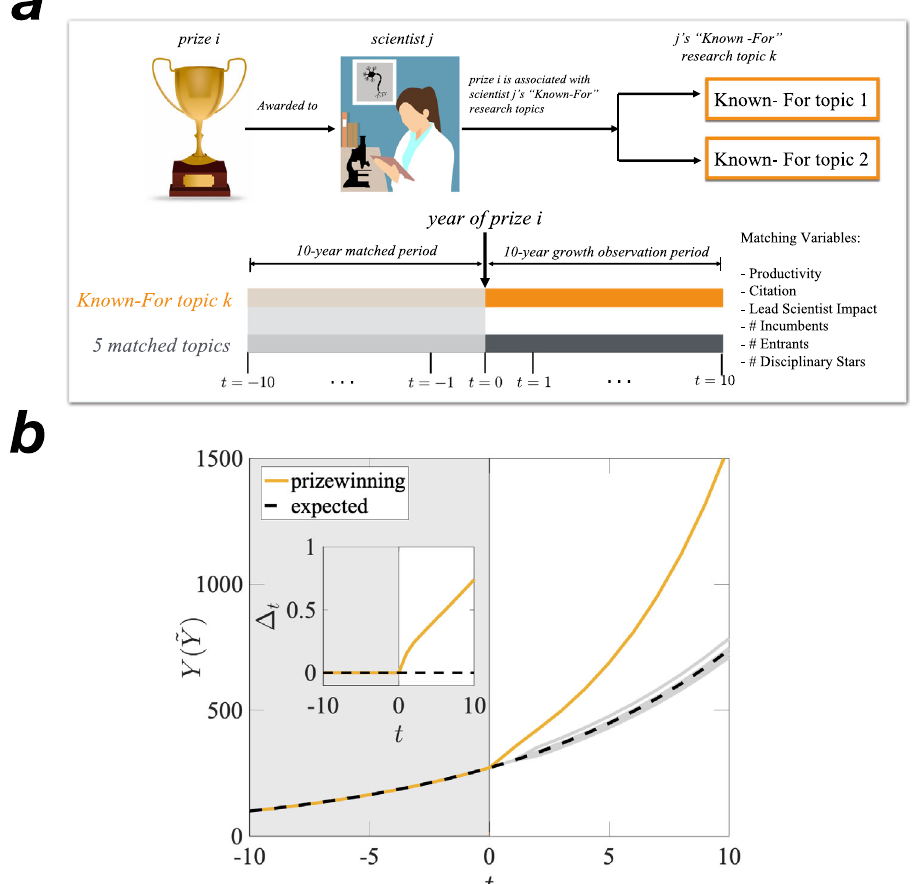
Fig. 1 Procedure for de fi ning prizewinning topics. a Our procedure has three steps. First, we collected a large sample of over 400 recognized prizes recorded in Wikipedia. Second, we linked prizes to prizewinners using the prize ’ s homepage and the prizewinner ’ s Wikipedia page. Third, we linked topics to prizes via the prizewinner ’ s Known For (KF) topics. KF topics are the subset of topics that a researcher is known for out of all the topics a researcher has worked on. We de fi ned a researcher ’ s KF topics as those topics on which the researcher had published 10 papers or more, which was cross-validated with Wikipedia ’ s KF topics pages. Wikipedia ’ s KF topic ’ s page uses crowdsourcing to identify a researcher ’ s KF topics (Robustness Check, Supplementary Fig. S1). For any known-for topic associated with a prize, we used MAG to verify that the prizewinner had publications on the known-for topic that predated the year of the associated prize. Each prizewinning topic was then matched with fi ve non-prizewinning topics that had statistically indistinguishable year- to-year growth from the prizewinning topic during the 10-year period prior to the prizewinning year as explained in detail in the main text. b Δ t measures the difference between the log of the average growth of prizewinning topics minus the log of the average growth of matched topics after the prize year. The inset shows Δ t as the relative percentage growth of the prizewinning topic compared to the matched topic group, hence the time prior to prize year, t = 0 is fl at. Δ t is measured and reported separately for 6 growth measures of a topic as described in the text. Gray panel represents the time before the prize year. Illustration images are from www.pxfuel.com and